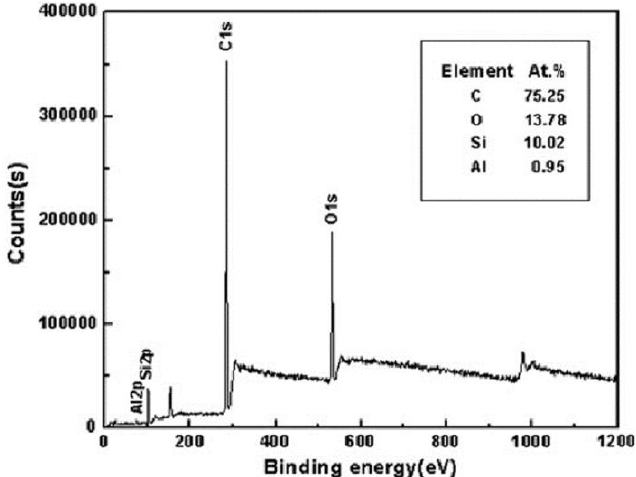
Figure 30. XPS spectral analysis of aluminum alloy superhydrophobic surface by laser treatment and DTS modification (Reprinted with permission from Ref. [106]. 2018, Li, D.W.).